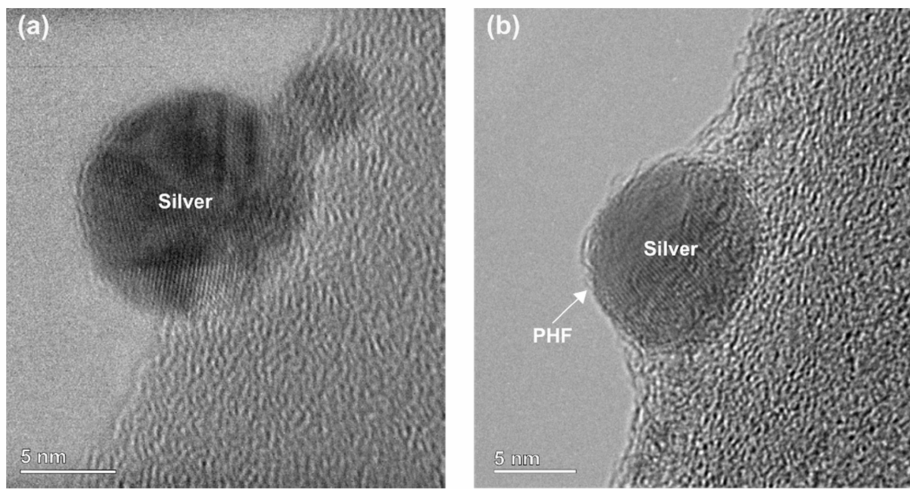
Figure 1. High-resolution transmission electron microscopy of citrate-AgNPs and PHF-AgNPs ( a and b , respectively), showing in both cases ~10 nm particles. The PHF-AgNPs often had well-defined capping features surrounding them, which can be attributed to PHF